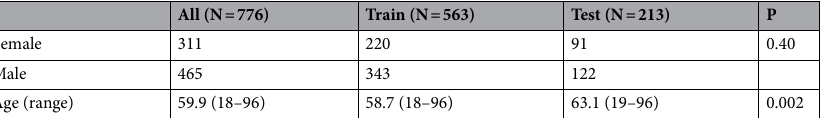
Table 1. Patient characteristics for the train and the test cohort. The P-value denotes the significance of a chi- square and a t-test for sex and age